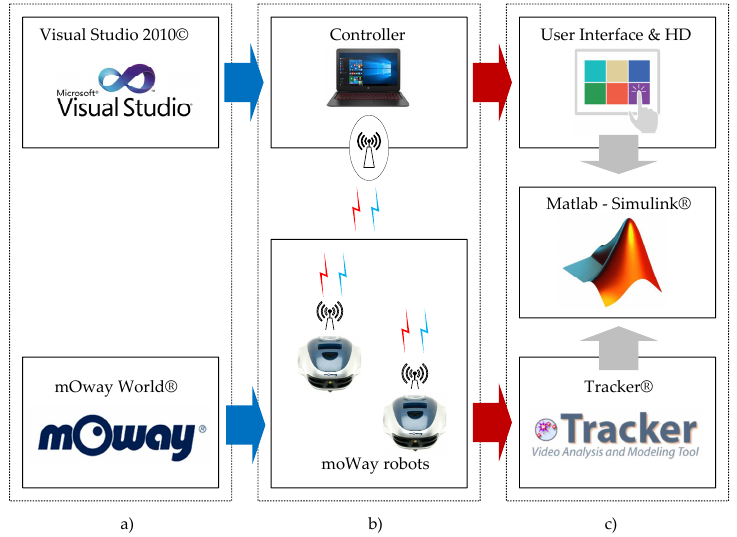
Figure 7. Laboratory for the experiments: ( a ) development module; ( b ) mobile robots environment; and ( c ) analysing tools.